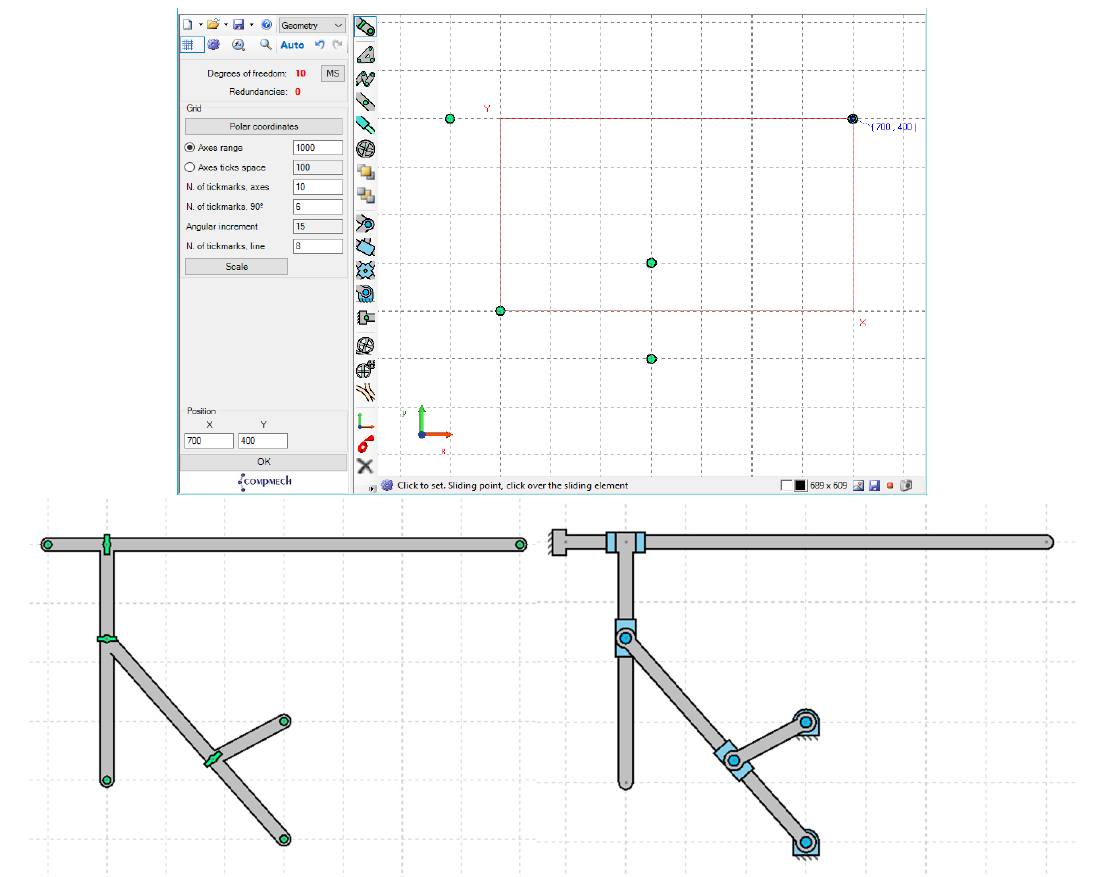
Figure 2. Main steps of geometric definition: 1—Nodes, 2—Elements, 3—Joints.